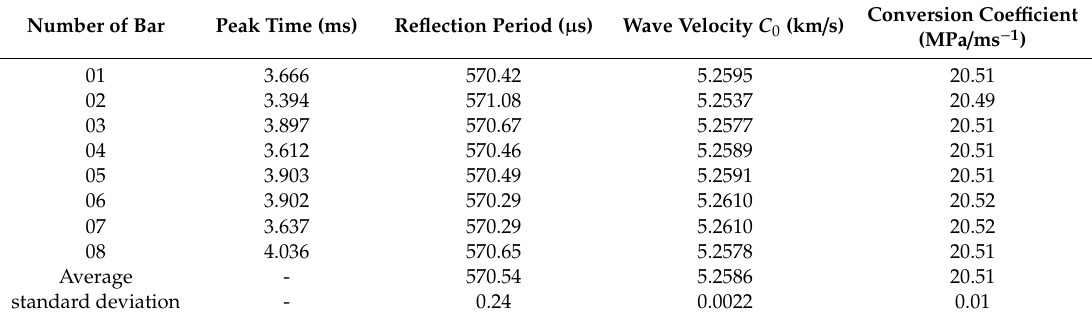
Figure 8. Typical velocity curve of free surface of pressure bar obtained by photonic doppler velocimetry (PDV). Table 3. The preliminary results of the pressure bar obtained by the testing experiment.